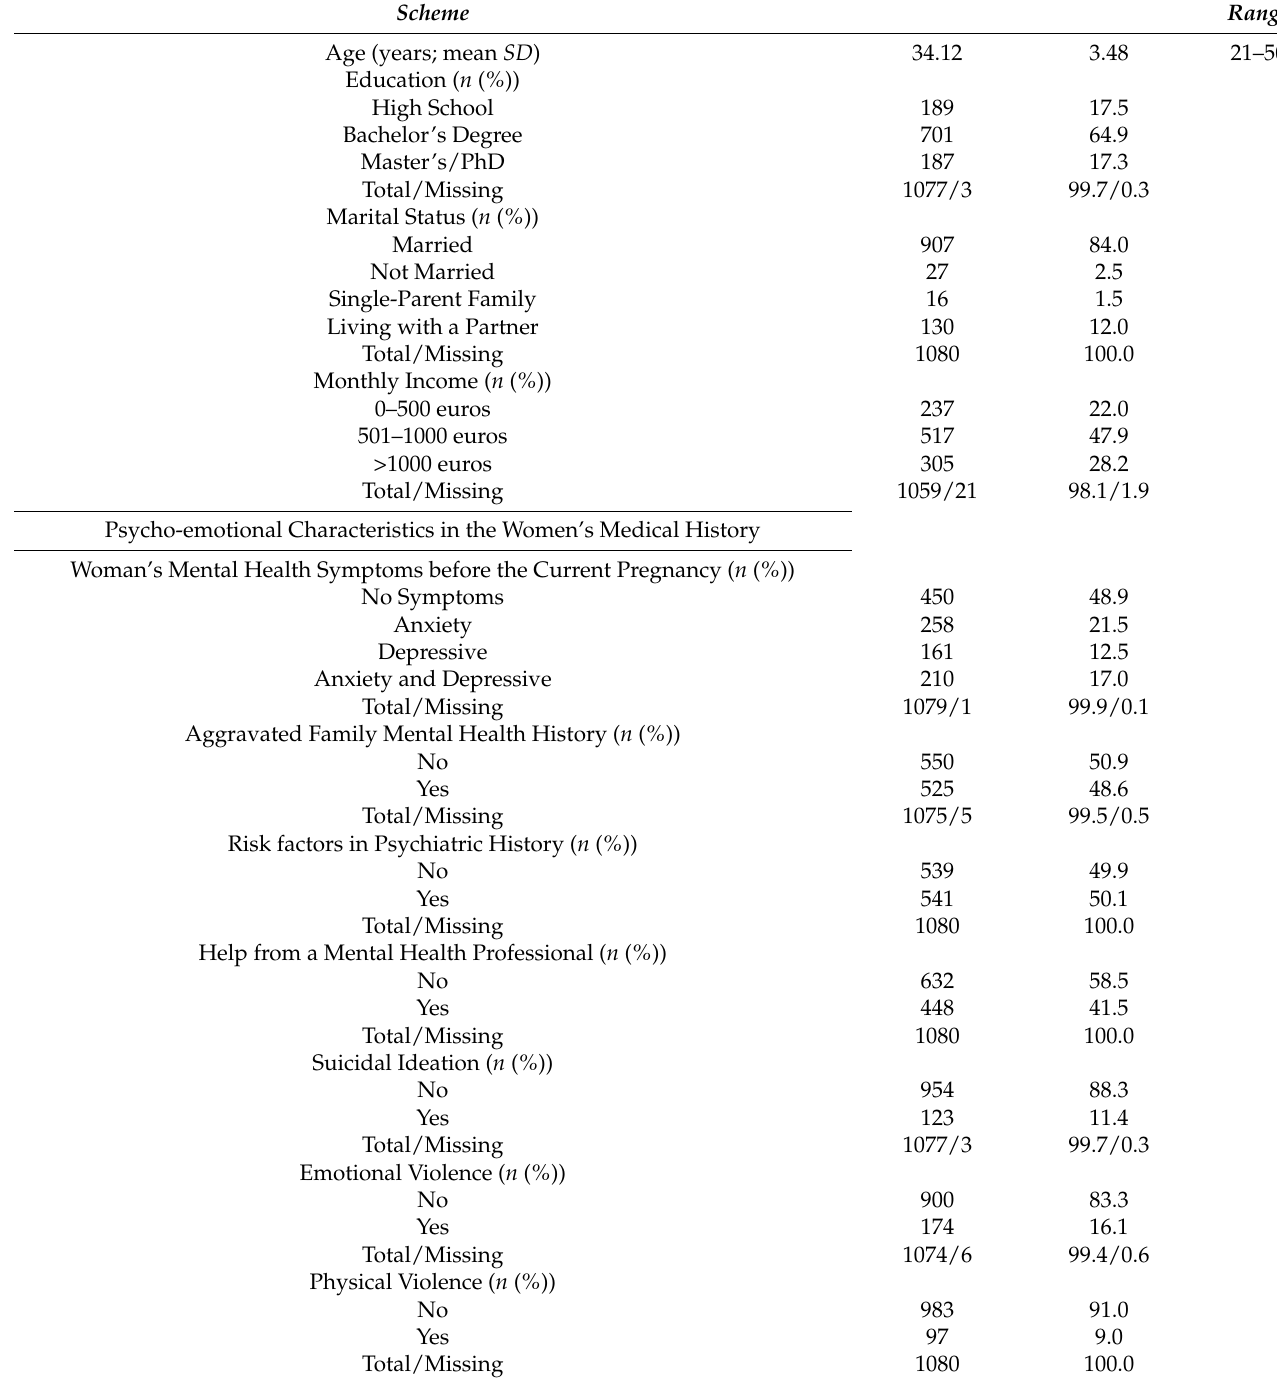
Table 1. Socio-demographic and psycho-emotional characteristics in the women’s medical